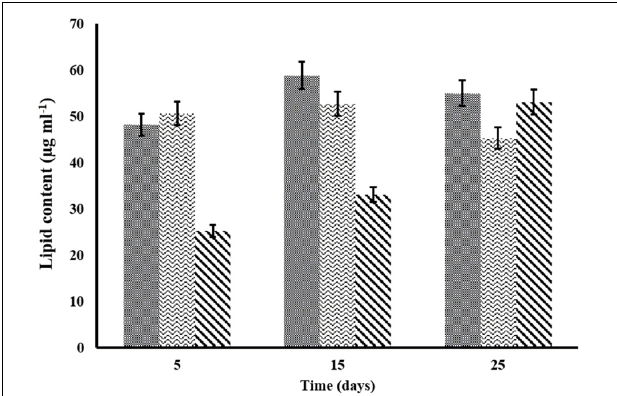
FIGURE 6 | Variation in the lipid content of microalgal species at different time intervals in the 3:1 ratio of DWW ( - C. pyrenoidosa - S. abundans and - A. ambigua ). Values represent the mean ± SD of three